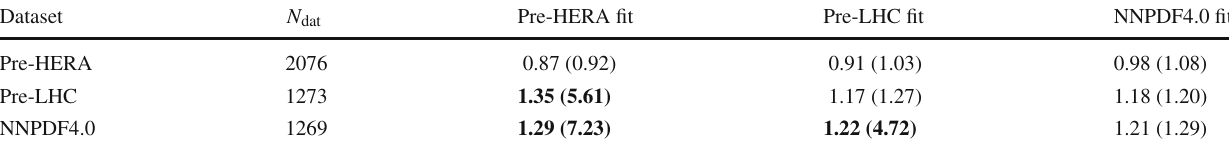
Table 2 χ 2 values per datapoint as obtained during a future test of the feature scaling methodology. The columns correspond to fits based on a given dataset, while the rows correspond to the datasets for which the χ 2 values are shown. While for the fit the dataset are inclusive (i.e., the NNPDF4.0 fit includes also the pre-LHC and pre-HERA datasets) the χ 2 is computed in an exclusive manner (i.e., the χ 2 as calculated for